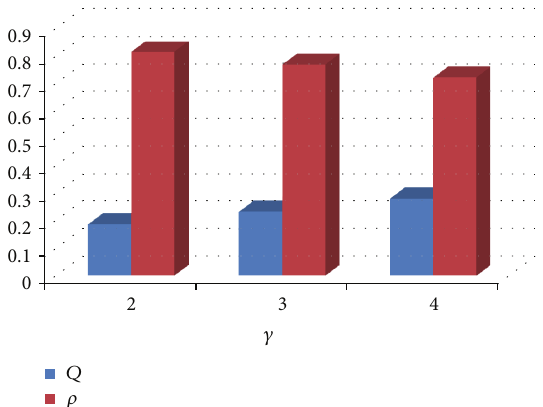
Figure 1: Effect of reneging parameter 𝛾 on the proportion of idle time 𝑄 and utilization factor 𝜌 (when 𝛼 = 2 , 𝛽 = 6 , 𝜂 = 5 , 𝜙 = 0.5) .